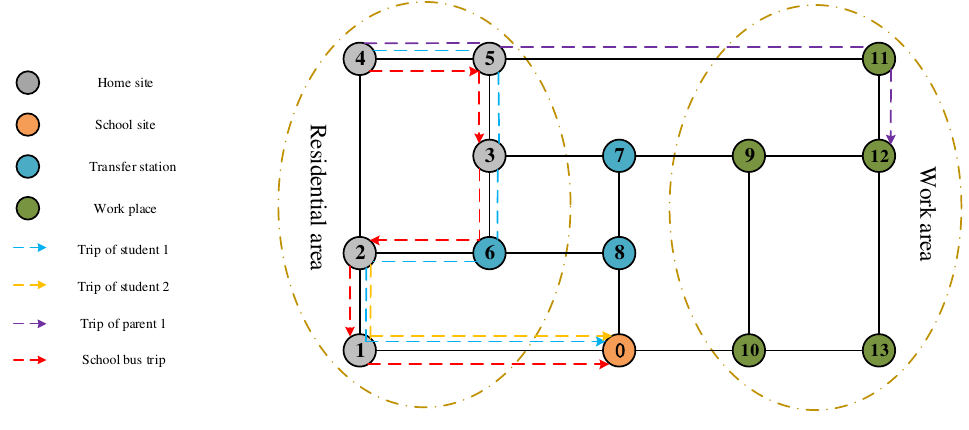
Figure 1. Network diagram of the school-bus commuting model.